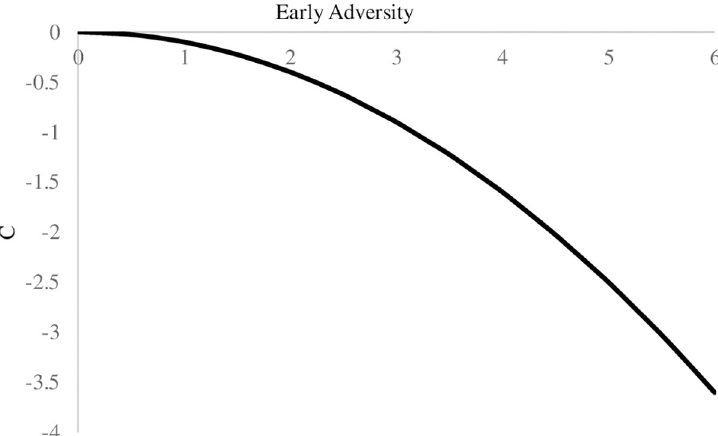
Fig 5. The effects of early adversity on conscientiousness after controlling for adulthood stressors exposure in the HRS sample. Adulthood stressors exposure included traumatic events and stressful life events. Traumatic events included experiences of disasters, physical attack, and death or illness of close others. Stressful life events included measures of events such as work and family/household related stressful experiences. C = Conscientiousness.